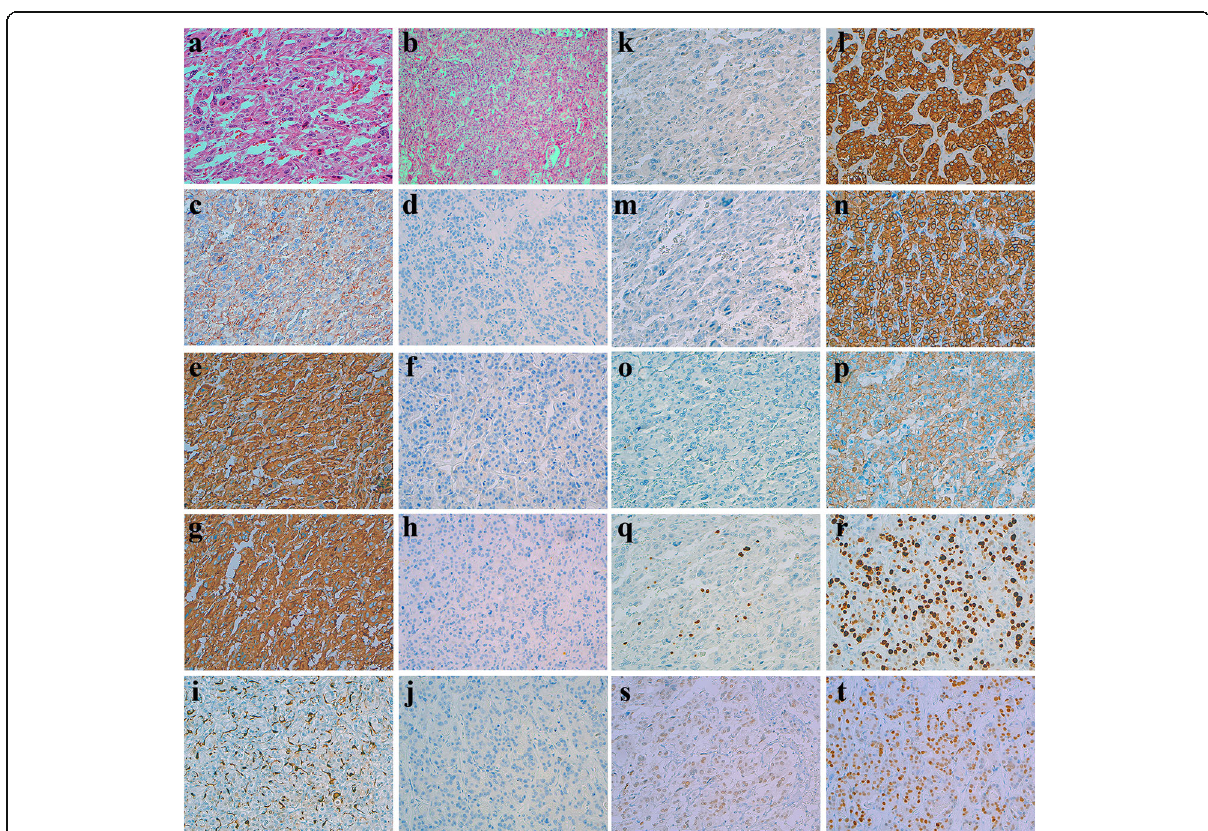
Fig. 4 Comparison of the two tumor components in morphology and IHC staining, × 200. Hematoxylin and eosin staining of two tumor cells ( a Pheochromocytoma, b Metastatic breast carcinoma). CD56 is expressed on the membrane of pheochromocytoma cells ( c Pheochromocytoma, d Metastatic breast carcinoma). CgA is diffusely expressed in pheochromocytoma ( e Pheochromocytoma, f Metastatic breast carcinoma). SYN is also diffusely expressed in pheochromocytoma cells ( g Pheochromocytoma, h Metastatic breast carcinoma). S100 is expressed in the sustentacular cells of pheochromocytoma ( i Pheochromocytoma, j Metastatic breast carcinoma). CK is stongly positive in metastatic breast cancer cells ( k Pheochromocytoma, l Metastatic breast carcinoma). HER-2 is stongly positive (3+) in metastatic breast cancer cells ( m Pheochromocytoma, m Metastatic breast carcinoma). E-cadherin is membrane positive in metastatic breast cancer cells ( o Pheochromocytoma, p Metastatic breast carcinoma). The proliferative index (Ki67) of pheochromocytoma is not more than 10% ( q ) and that of metastatic breast cancer is about 70% ( r ). GATA-3 is weakly positive in pheochromocytoma cells ( s ) and significantly positive in metastatic breast cancer cells ( t